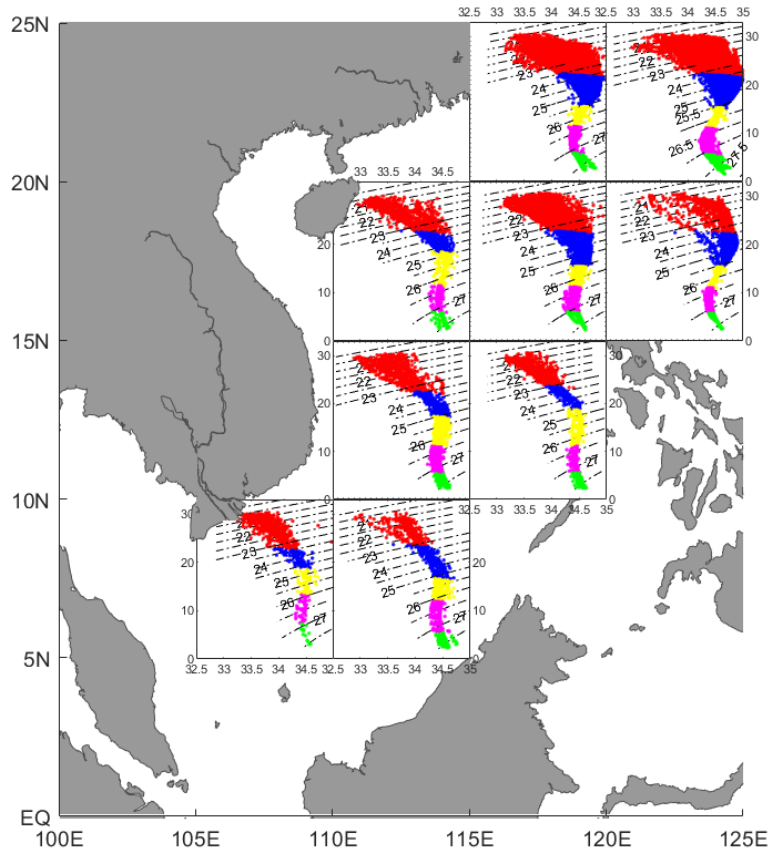
Figure 6. The same as Figure 5 but in